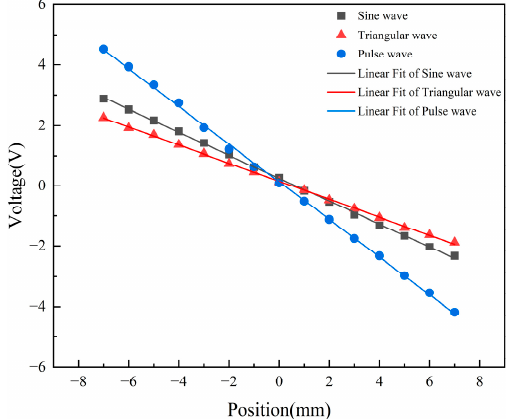
Figure 10. Output voltage at different positions. Table 2. Linear fitting parameters of output voltage.